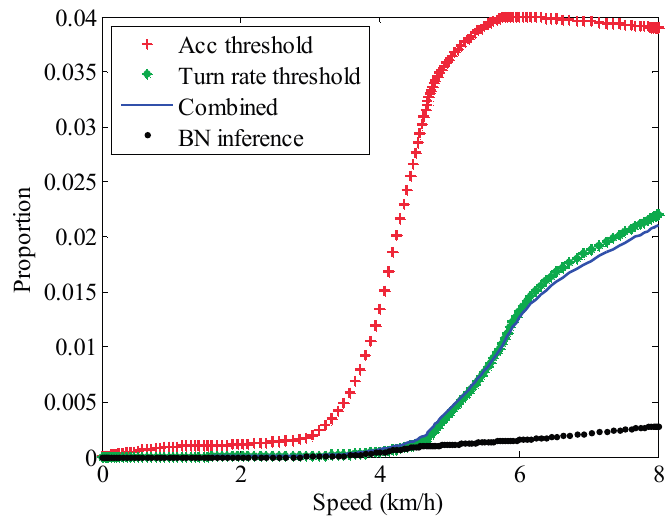
Figure 11. The comparison of ZV false detections between the combined condition method and the BN inference method.